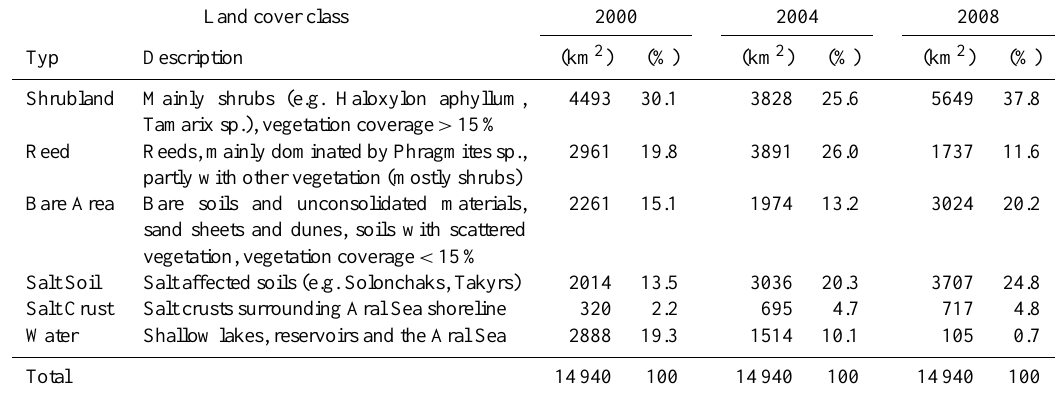
Table 1. Matrix of land cover change derived from MODIS time series classification. Area statistics for 2000, 2004 and 2008. Land cover class 2000 Typ Description (km 2 ) Shrubland Mainly shrubs (e.g. Haloxylon aphyllum, Tamarix sp.), vegetation coverage > 15% Reed Reeds, mainly dominated by Phragmites sp., partly with other vegetation (mostly shrubs) Bare Area Bare soils and unconsolidated materials, sand sheets and dunes, soils with scattered vegetation, vegetation coverage < 15% Salt Soil Salt affected soils (e.g. Solonchaks, Takyrs) Salt Crust Salt crusts surrounding Aral Sea shoreline Shallow lakes, reservoirs and the Aral Sea